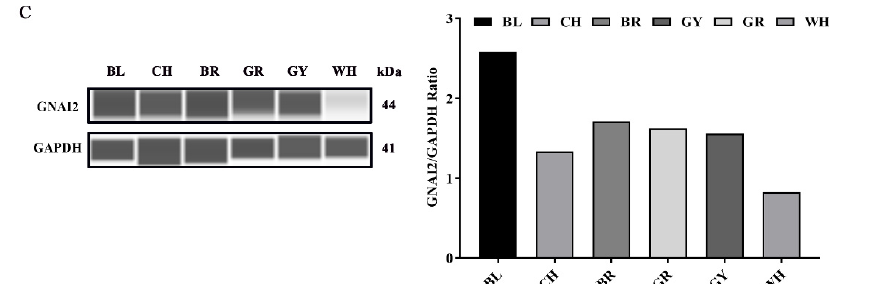
Figure 1. The expression levels of GNAI2 in the skin of rabbits of different coat colors: ( A ) the rabbit GNAI2 cDNA was successfully cloned. M, DL2000 DNA marker; lane 1, the coding sequence (CDS) of GNAI2; ( B ) the GNAI2 mRNA levels in the skin of rabbits of different coat colors were determined. Samples were in triplicates and the relative expression levels of the genes were determined using GAPDH as an internal control and the 2 − ∆∆ Ct method. Duncan’s Multiple Range Test was employed to compare the differences across groups. Small letters indicate significant differences among groups ( p < 0.05); ( C ) the GNAI2 protein expression in the rabbit skin was measured using the Wes assay. Differential expression of GNAI2 in Rex rabbits with different coat colors was calculated using the relative expression ratio of GNAI2/GAPDH. BL, black; CH, chinchilla; BR, brown; GR, gray; GY, gray-yellow; WH, white.